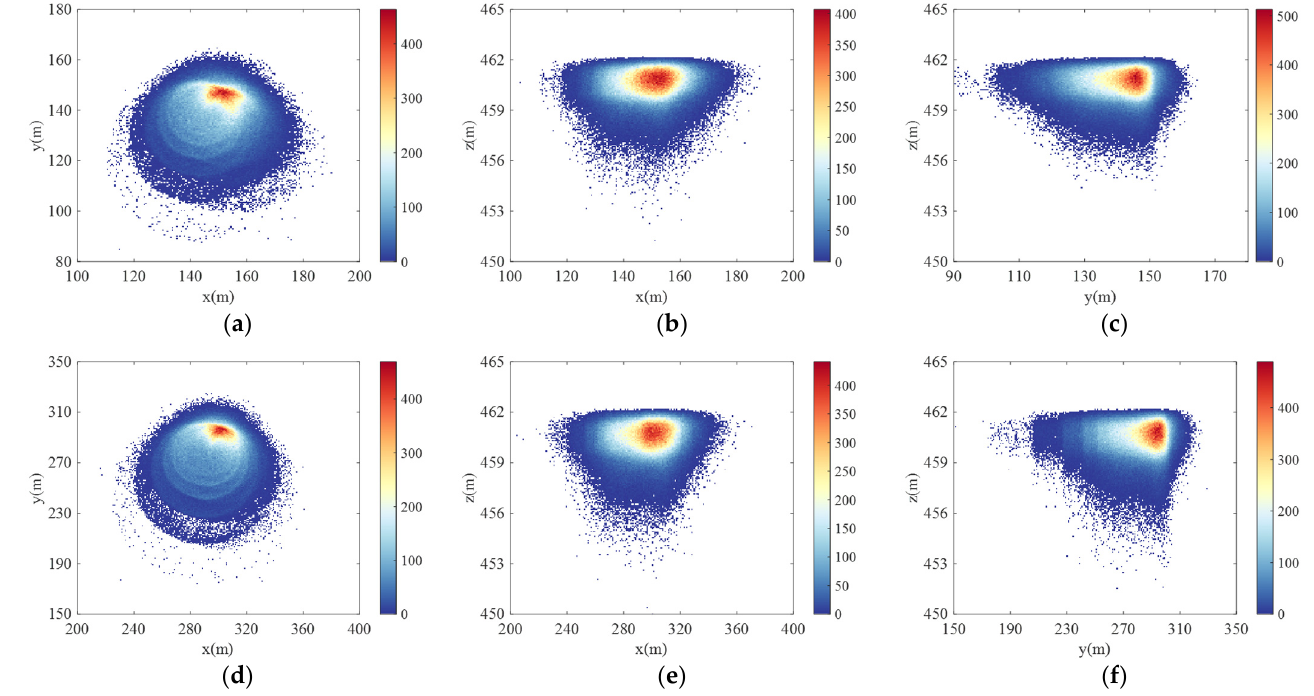
Figure 9. The projection of the density distribution of a chaff cloud in space on the coordinate plane. ( a ) wind speed (5, 5, 0) m/s, x O y plan; ( b ) wind speed (5, 5, 0) m/s, x O z plan; ( c ) wind speed (5, 5, 0) m/s, y O z plan; ( d ) wind speed (10, 10, 0) m/s, x O y plan; ( e ) wind speed (10, 10, 0) m/s, x O z plan; ( f ) wind speed (10, 10, 0) m/s, y O z plan.